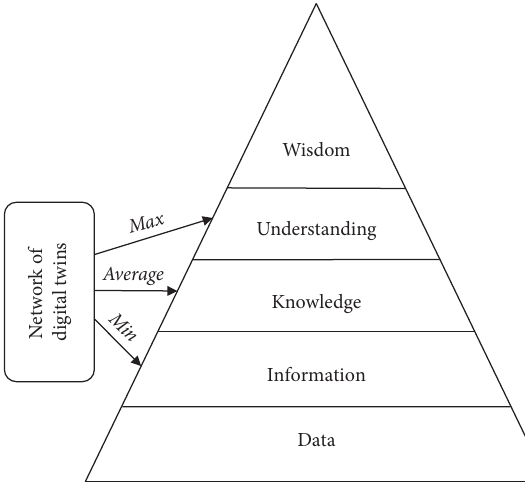
Figure 10: Network of digital twins and DIKW